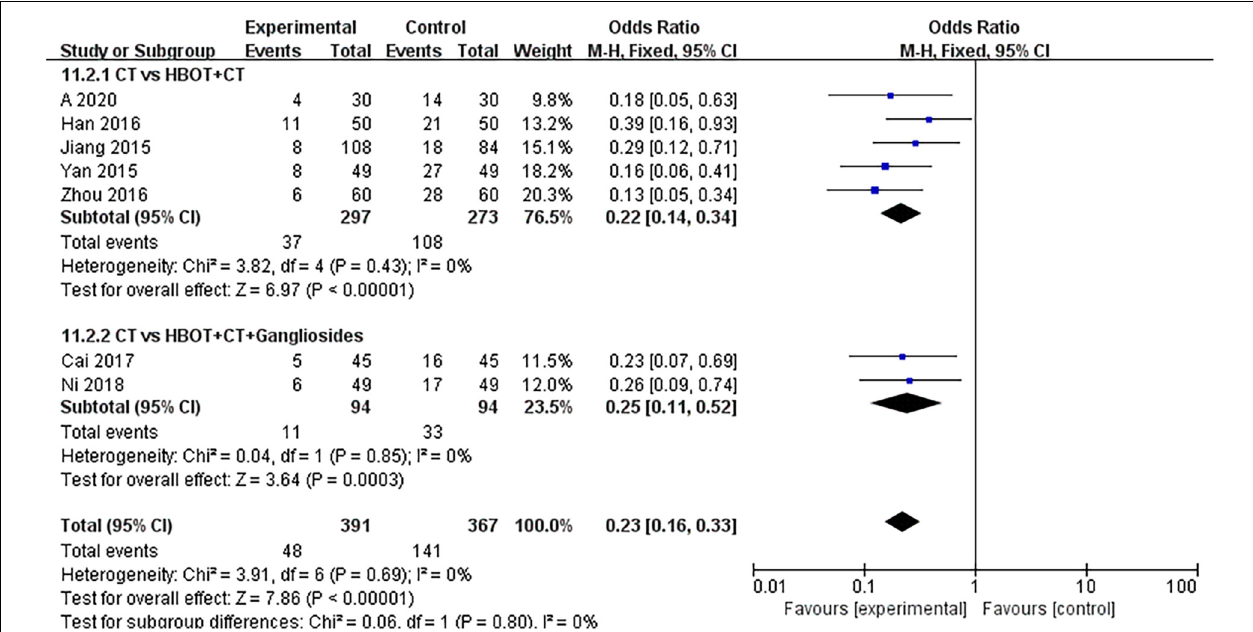
FIGURE 5 | Subgroup analysis of risk of sequelae: (1) CT vs. HBOT + CT; (2) CT vs. HBOT + CT +